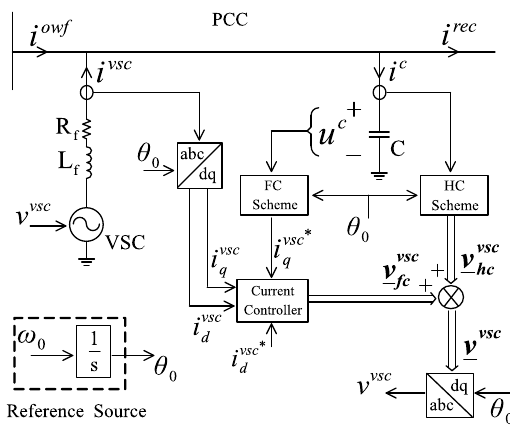
Figure 3. Overall system control loops.